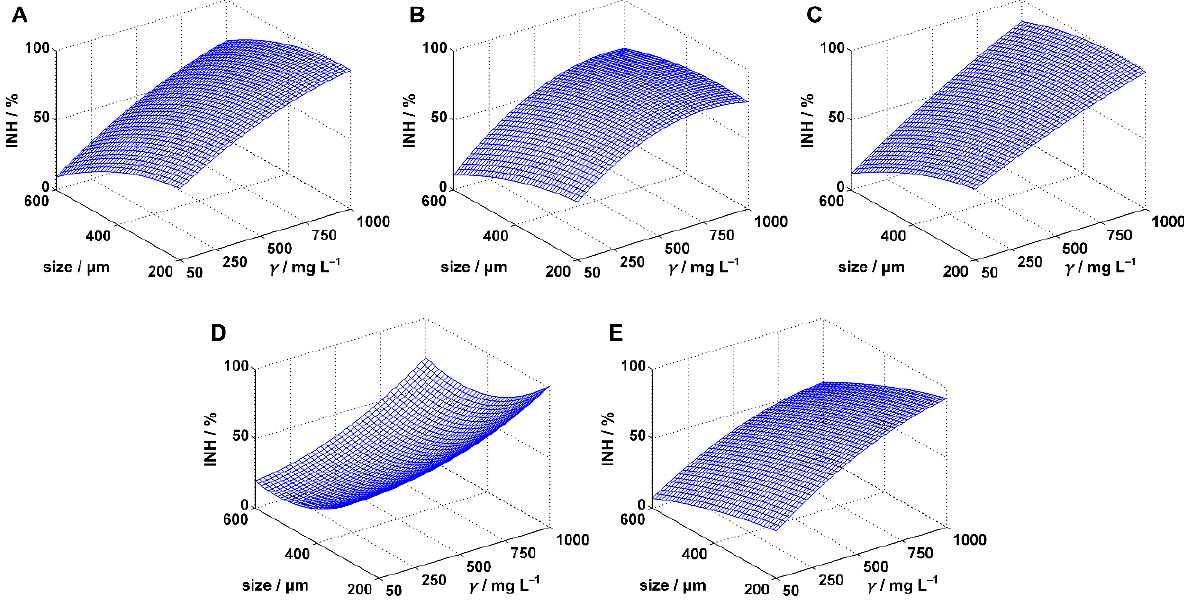
Figure 3. Inhibition surfaces estimated for Saccharomyces cerevisiae by the best regression models. The cases are: ( A ) polyethylene, ( B ) polypropylene, ( C ) polystyrene, ( D ) polyvinyl chloride, and ( E ) polyethylene terephthalate.